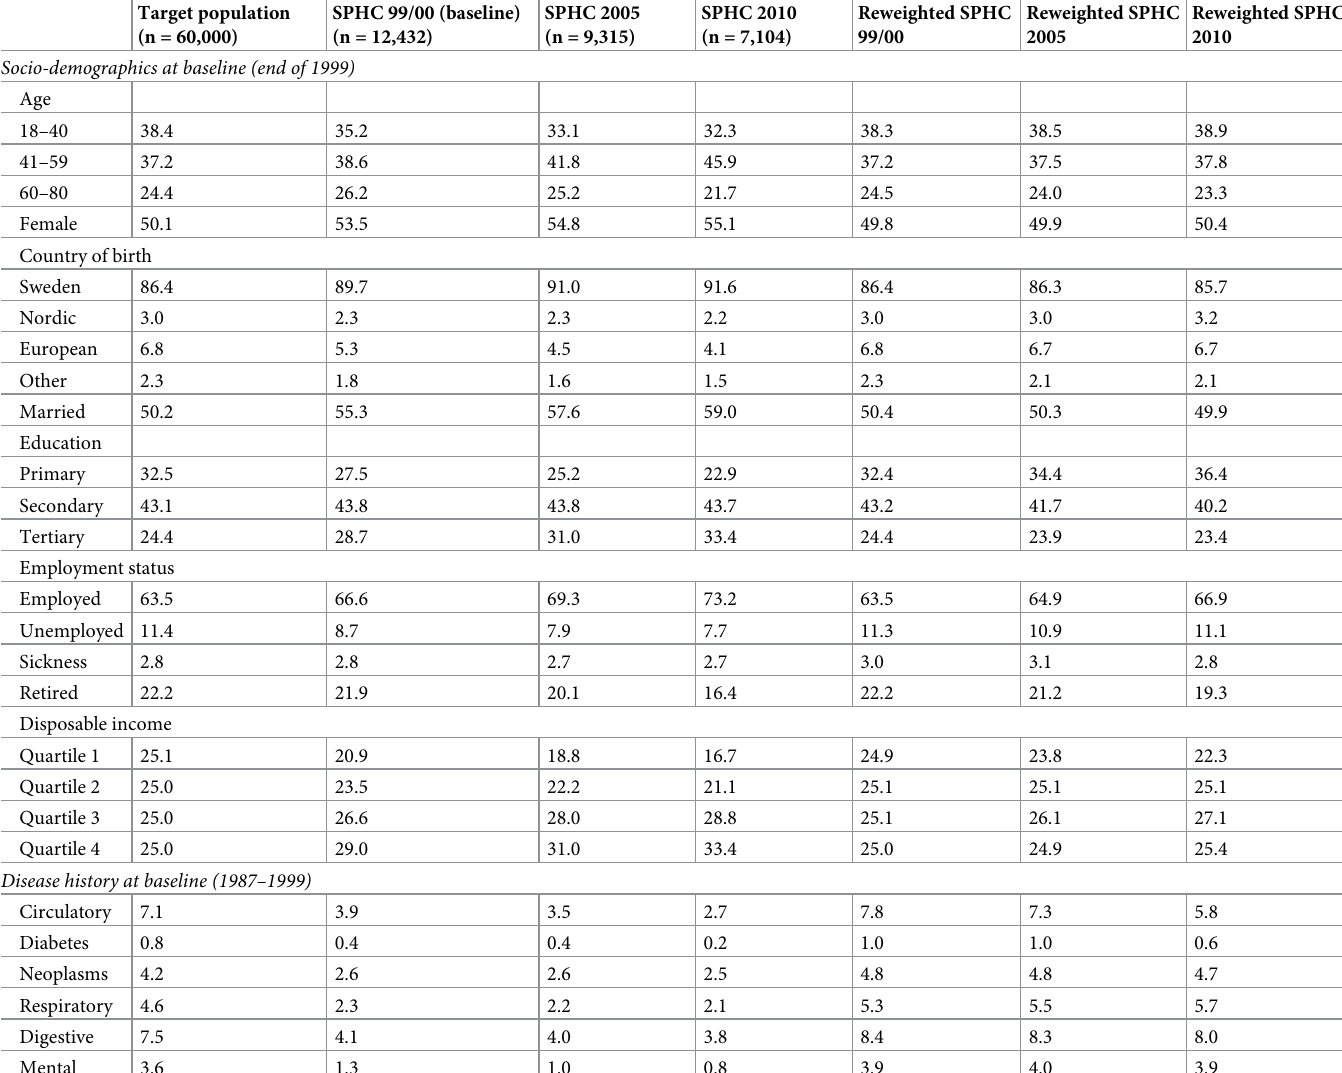
Table 1. Background characteristics that were used to estimate baseline participation